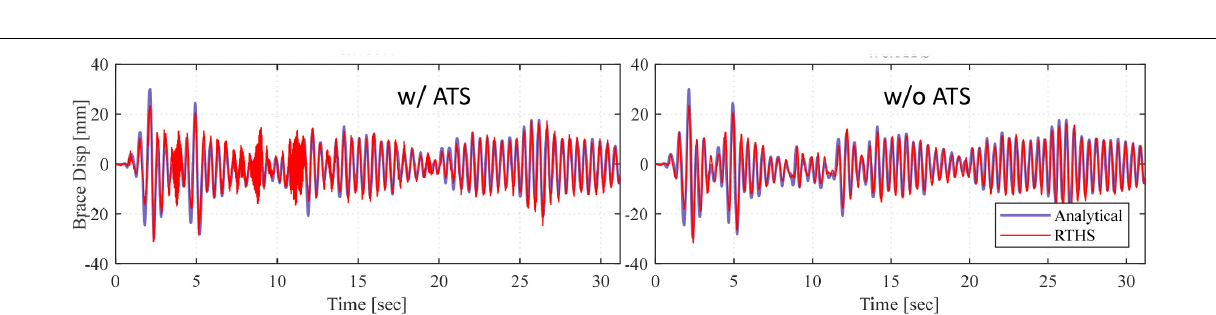
FIGURE 22 | RTHS response comparison with analytical solution for Model 1 (S L = 15) with and without using ATS when the first row of the force input was selected to be updated.